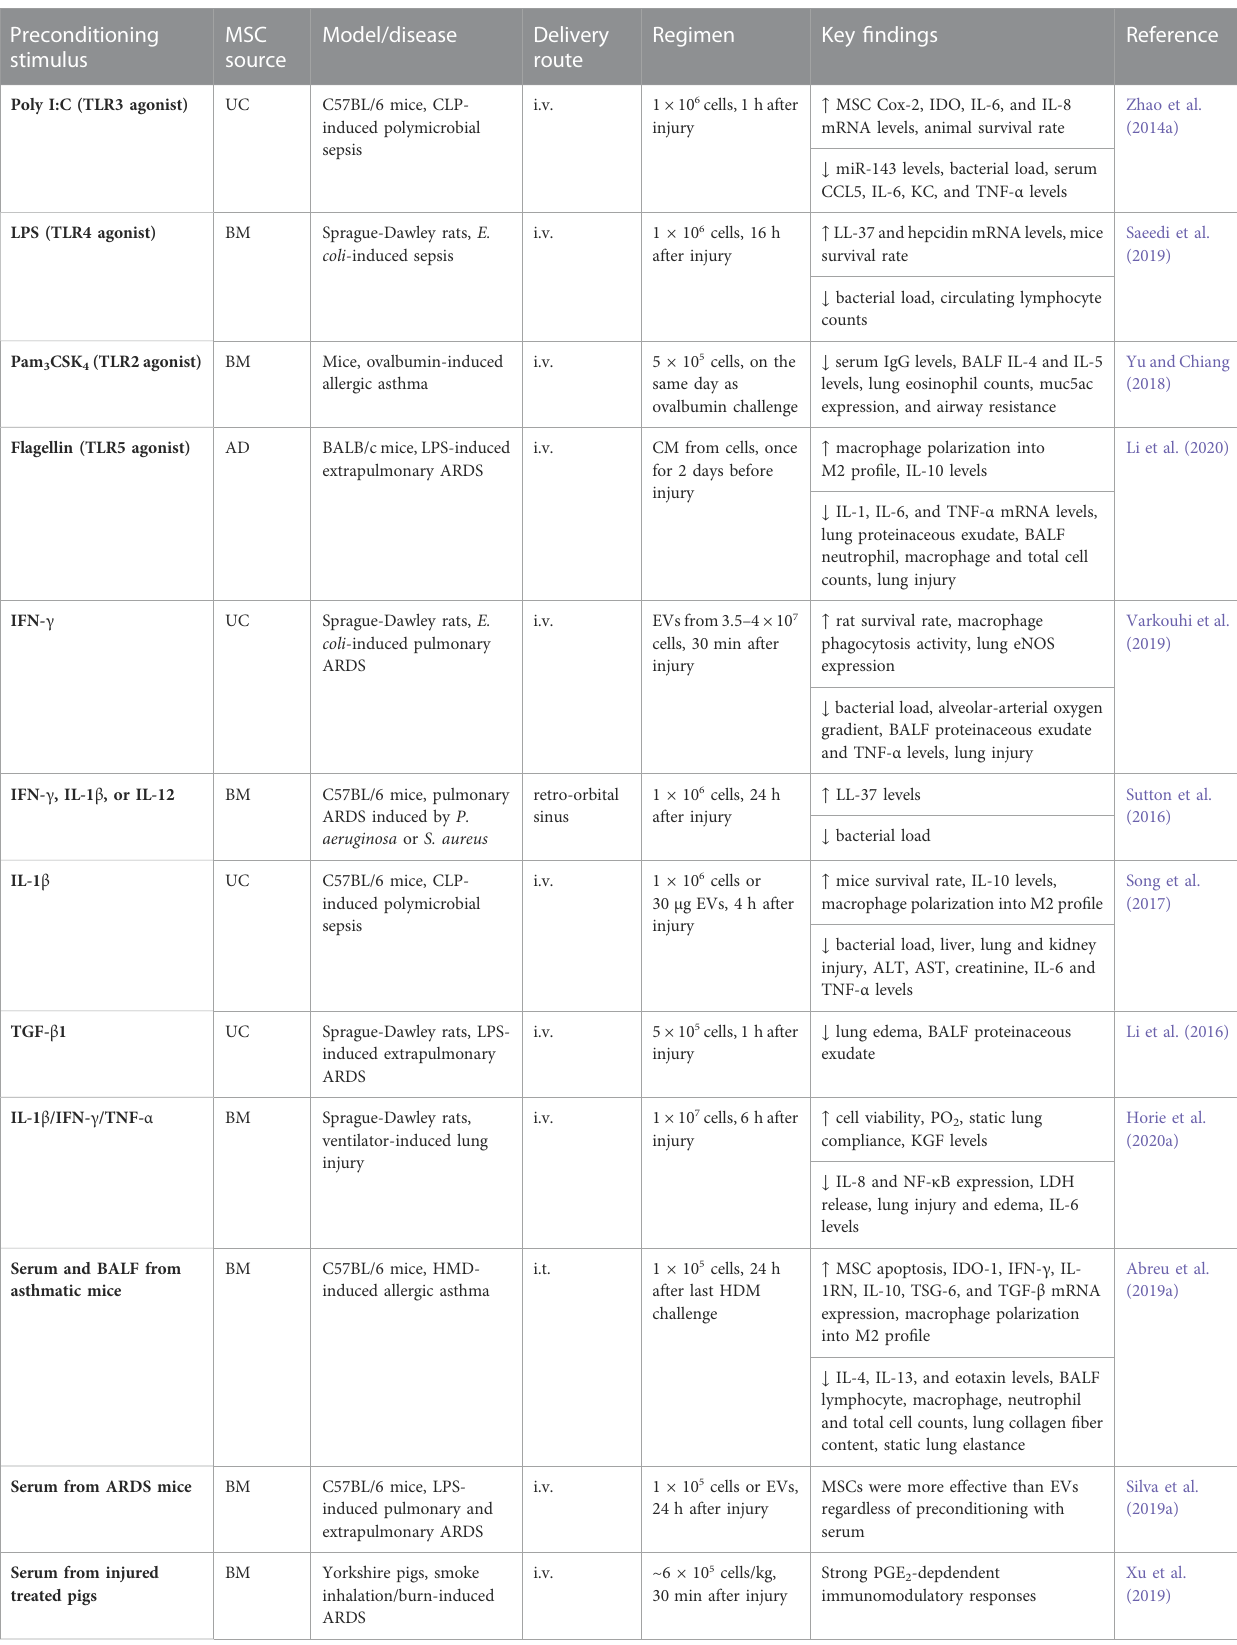
TABLE 2 In vivo preclinical studies assessing the ef fi cacy of MSC preconditioning in in fl ammatory conditions. Preconditioning